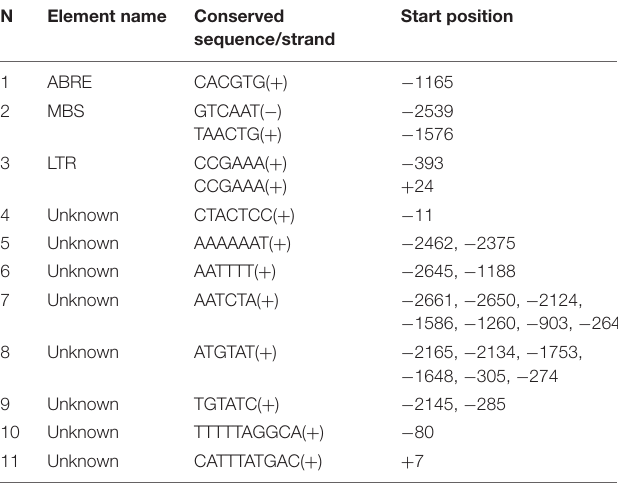
TABLE 1 | Predictions of cis -elements present in the TaSnRK2.8